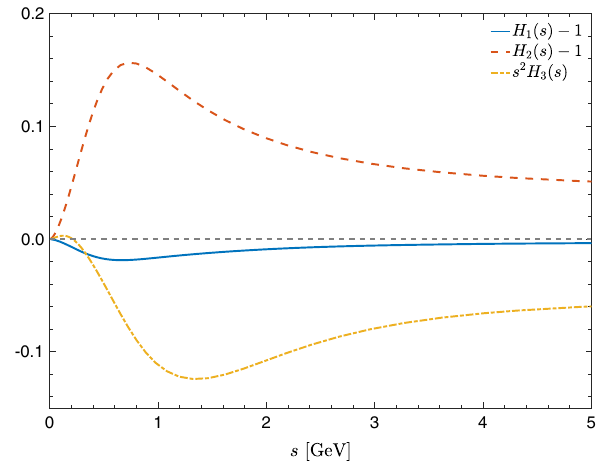
Fig. 5 The deviations of the combinations H 1 ( s 2 ) , H 2 ( s 2 ) , and s 2 H 3 ( s 2 ) , defined in the Eq. (4.2), from their tree-level